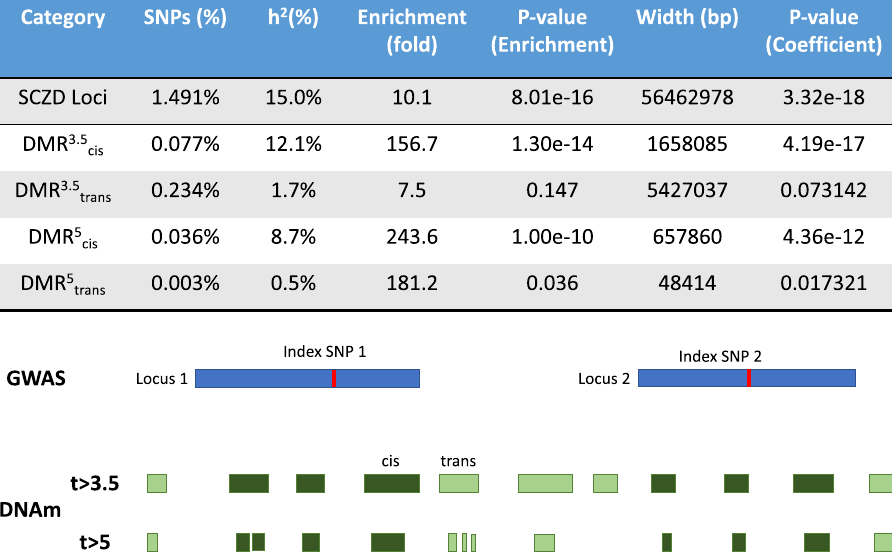
Fig. 4 LDSC results for schizophrenia heritability. (Top) LDSC analysis outputs for each category of gDMRs are explained here. Results showed that most of the enrichment for schizophrenia heritability in our gDMR sites was in cis . (Bottom) Visual description of LDSC: we performed LDSC analysis on the GWAS-identi fi ed loci as a background, and two sets of gDMRs, one with a cutoff of t > 3.5 and one with a more stringent cutoff of t > 5. We further divided these gDMR sets into cis gDMRs — those within the GWAS loci — and trans gDMRs — those outside the GWAS loci. P -values presented here are not adjusted for multiple testing, though multiple testing correction was used to determine signi fi cance in these